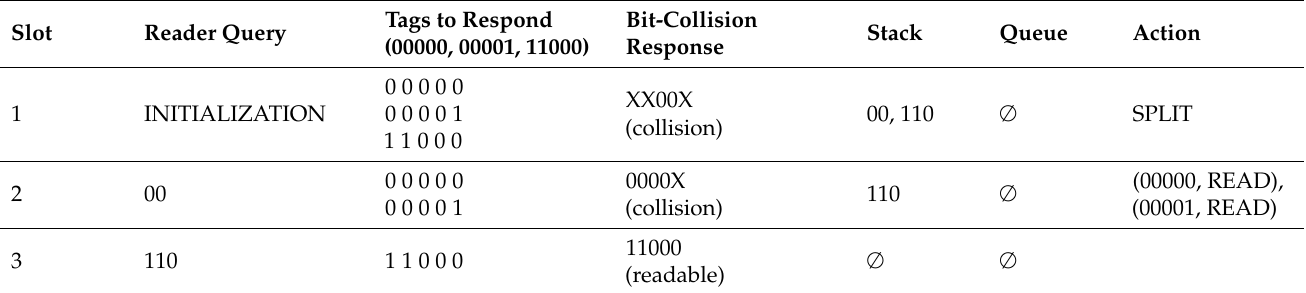
Table 2. An example of BKQT identification.